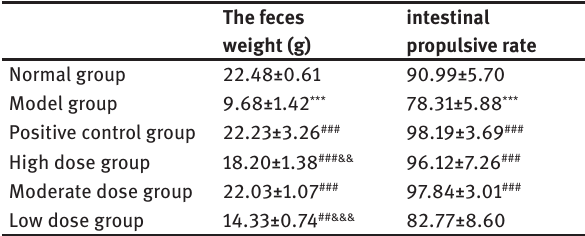
Table 2: Rat granules and intestinal propulsive rate at 6 h after treatment.